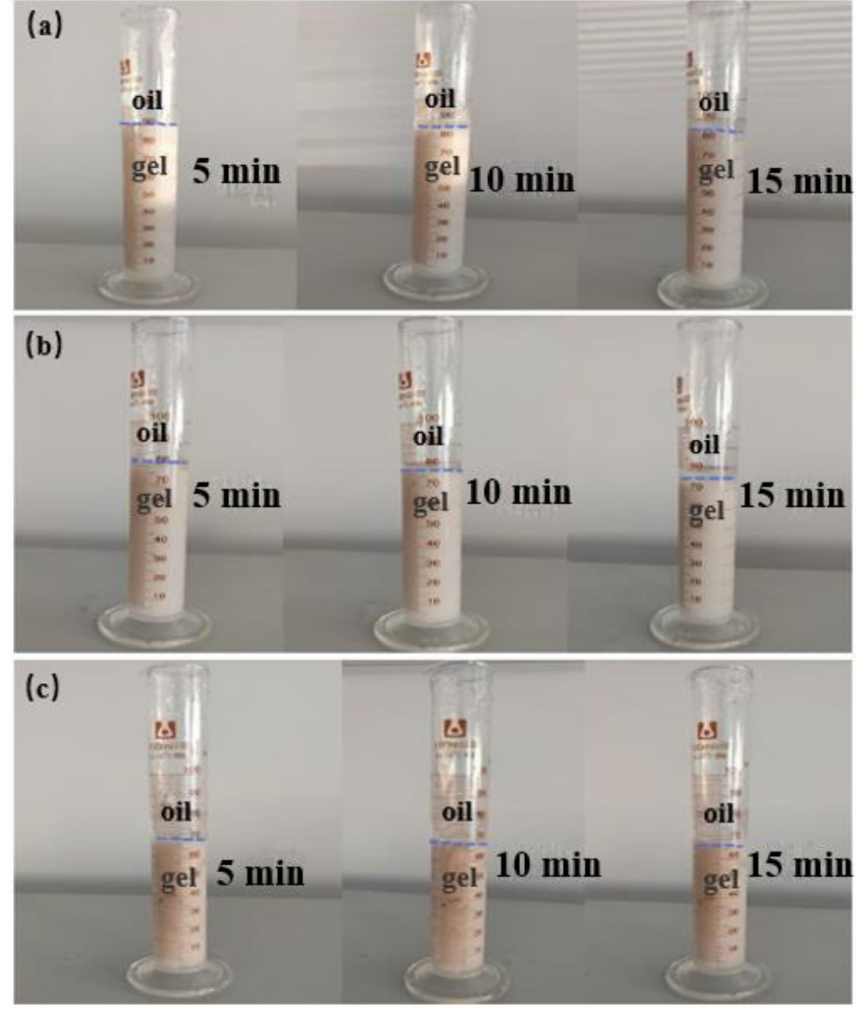
Figure 4. The experimental results of dilute gel system with white oil: ( a ) Gel:white oil = 9:1; ( b ) gel:white oil = 8:2; ( c ) gel:white oil = 7:3.